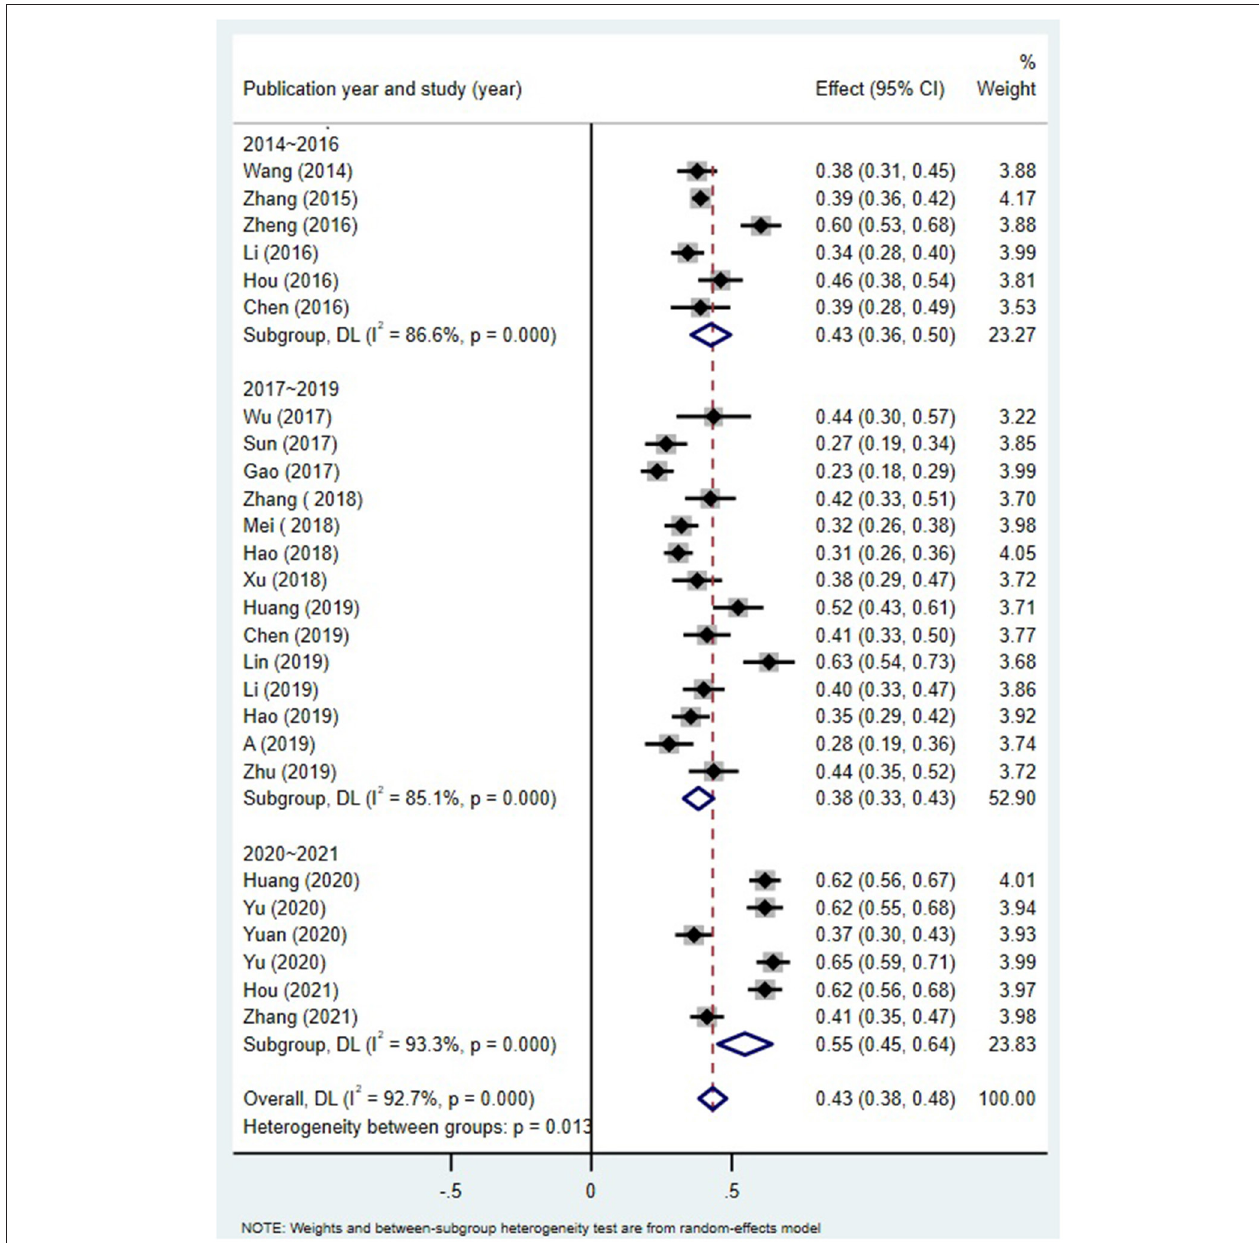
FIGURE 4 | MPA and alexithymia: an analysis of the moderating effects of publication year.